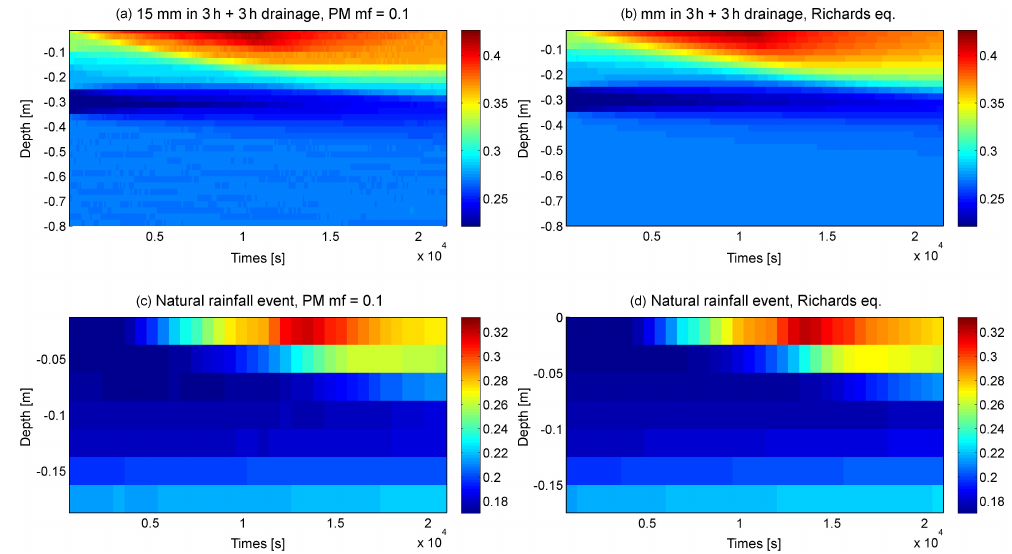
Figure 8. Time series of simulated soil moisture profiles in the upper 80cm/20cm of the Calcaric Regosol on loess for a block rain of 20mm in 1 and 2h of subsequent drainage ( a and b ) starting from an S-shaped soil moisture profile and for the nocturnal rainfall event observed in May in the Weiherbach catchment ( c and d ).